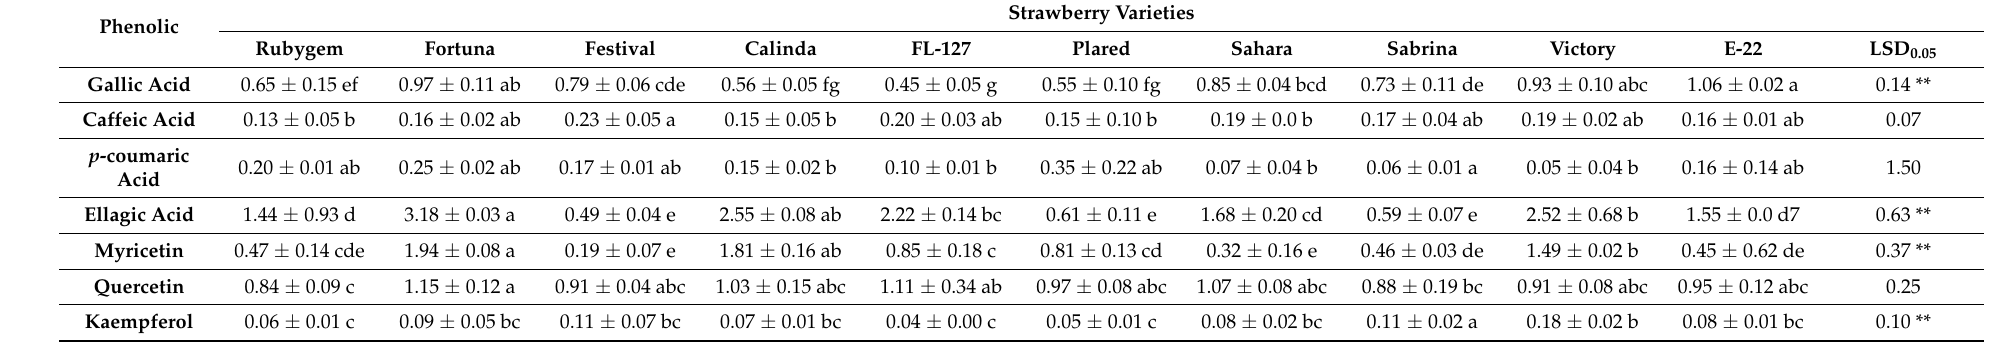
Table 4. The content of phenolic compounds (mg 100 g − 1 FW) in fruits of ten strawberry